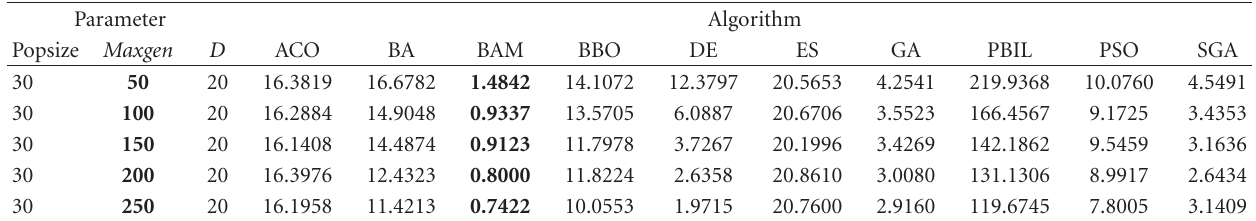
Table 4: Mean normalized optimization results on UCAV path planning problem on di ff erent Maxgen . The numbers shown are the minimum objective function values found by each algorithm, averaged over 100 Monte Carlo simulations.